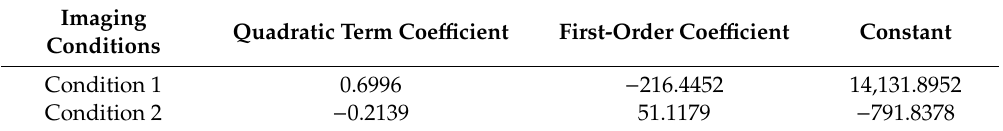
Table 1. Quadratic function fitting parameters.